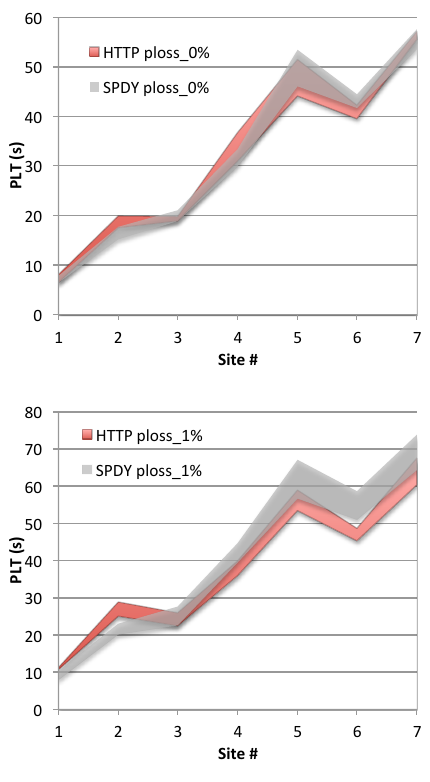
Figure 4. Per-site average PLT values. Sites have been numbered according the rank of Table 1 (Wikipedia is 1 , and Huffington Post is 7